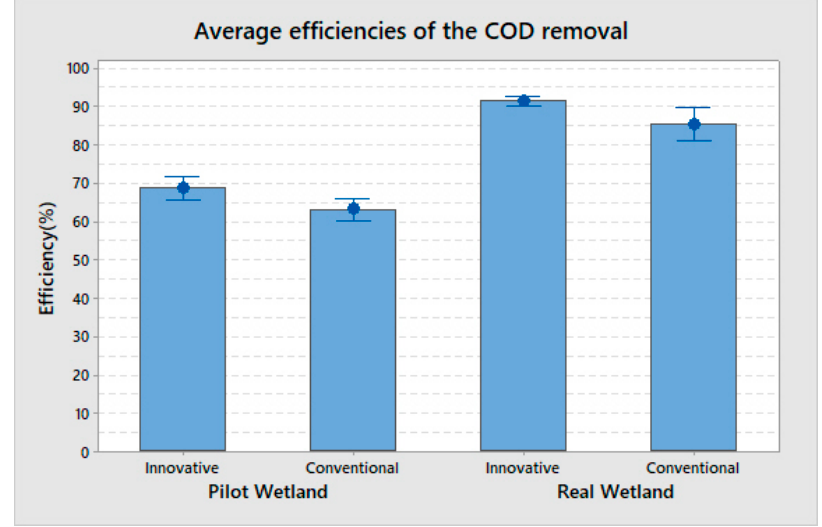
Figure 10. The average removal efficiencies COD and the dispersion of both devices. The individual standard errors were used to calculate the interval (95% confidence grade for the mean).